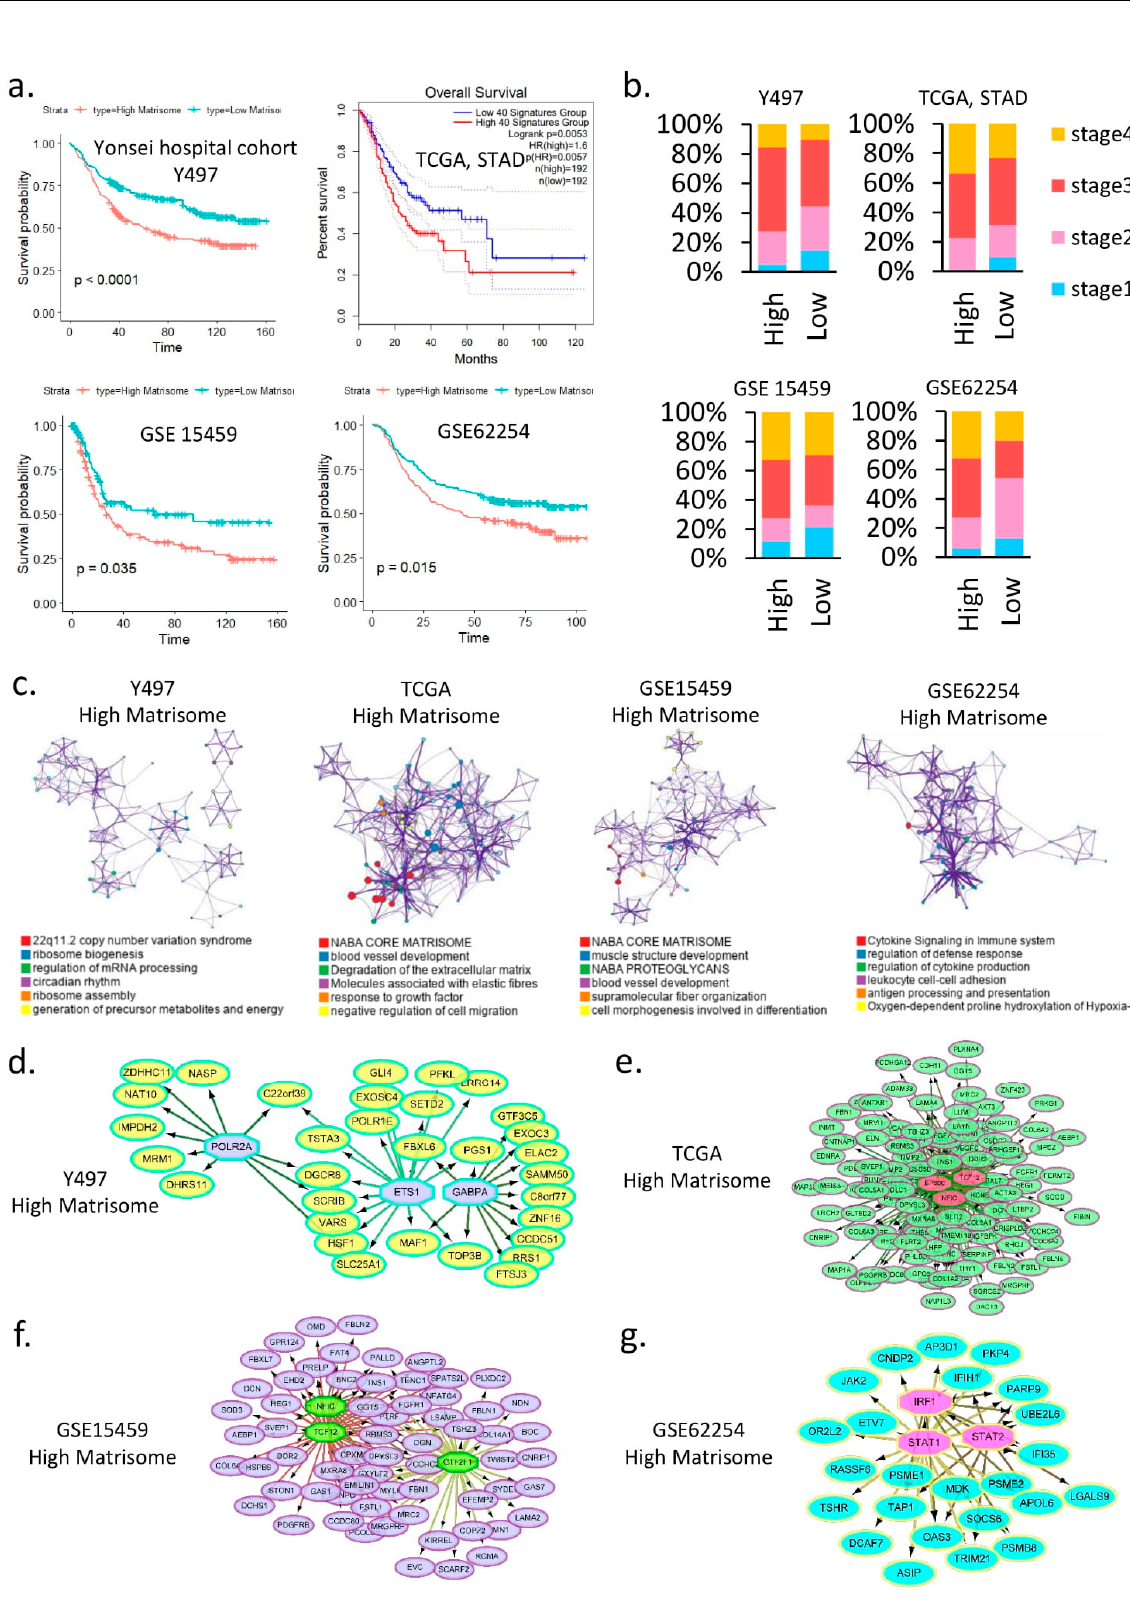
Figure 3. High-matrisome type is associated with poor prognosis in gastric cancer. ( a ) Kaplan–Meier plots show the overall survival rates for the high- and low-matrisome groups. The p -values were ana- lyzed using the log-rank test and adjusted by Bonferroni correction. ( b ) Bar graph showing the tumor stages for the high- and low-matrisome groups. ( c ) Network of gene ontology analysis of high- matrisome groups of 4 cohorts (FDR < 0.001). ( d ) Network of transcription factor target genes and